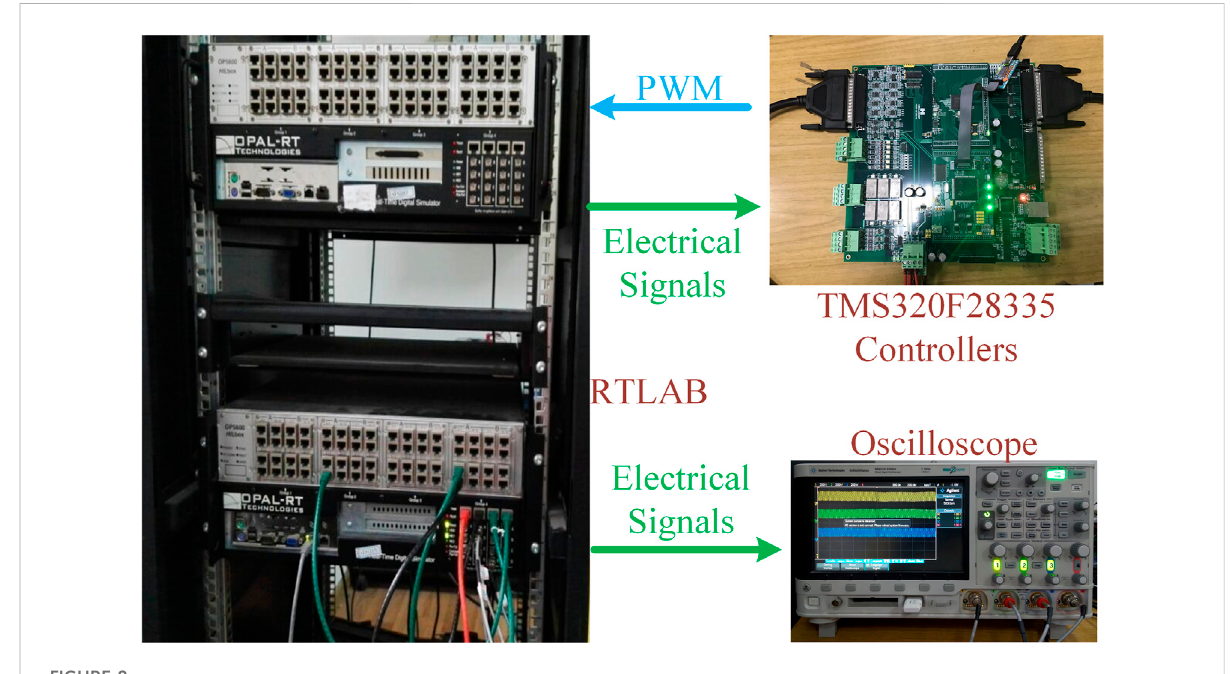
FIGURE 8 Experimental equipment